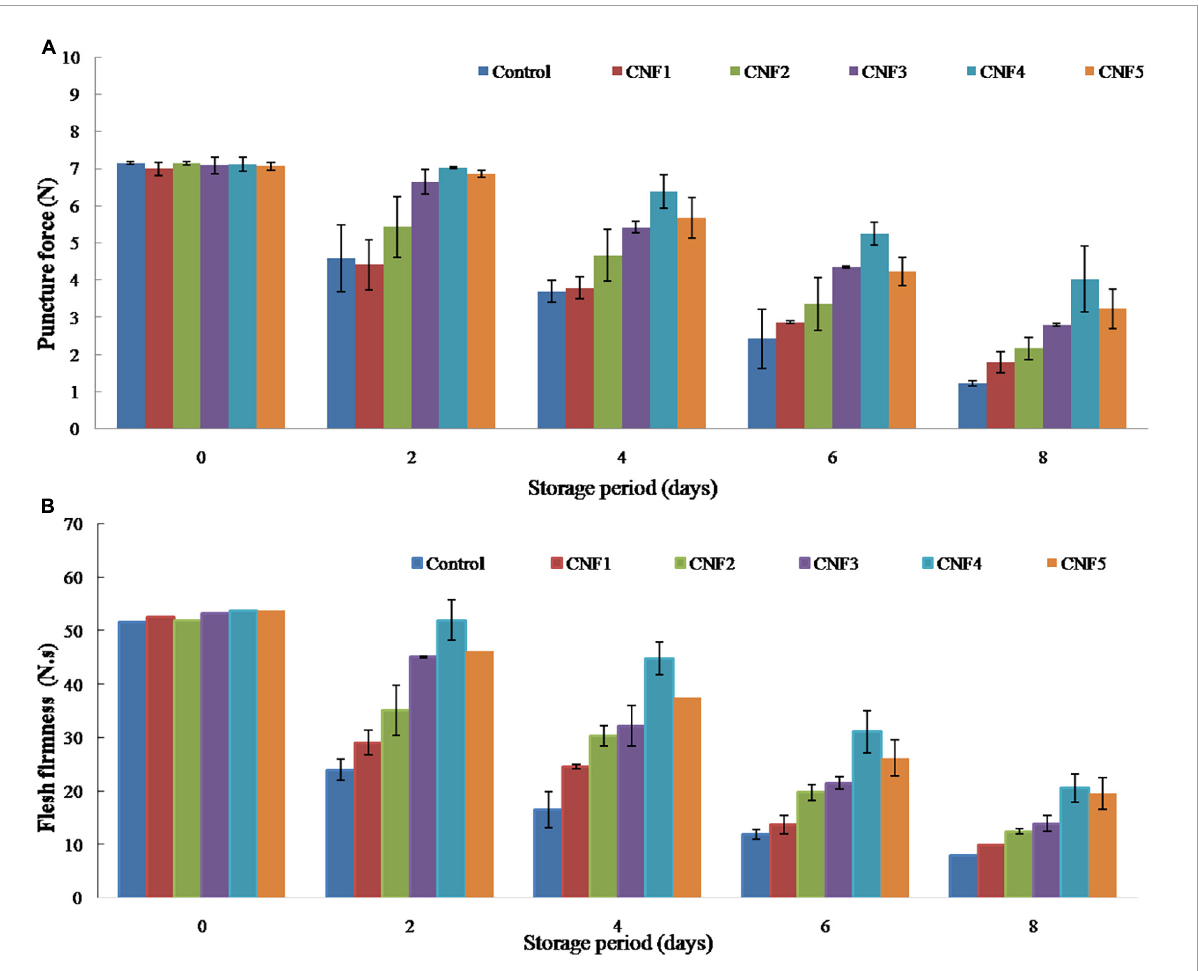
FIGURE4 Puncture force (A) and flesh firmness (B) of sapota fruits stored in corrugated fibre board boxes containing CNF during storage at 26 ± 2 ◦